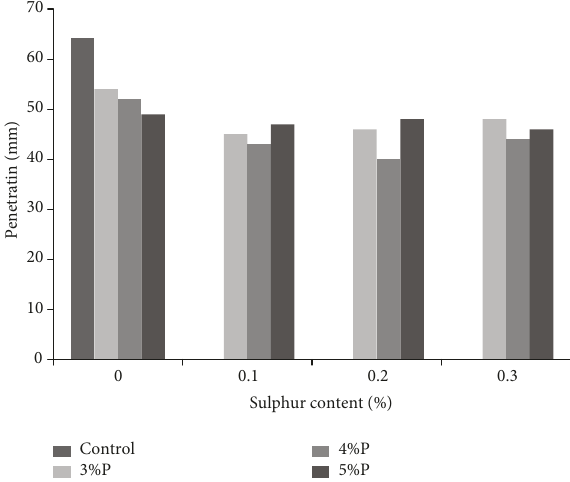
Figure 3: Penetration of base and modified